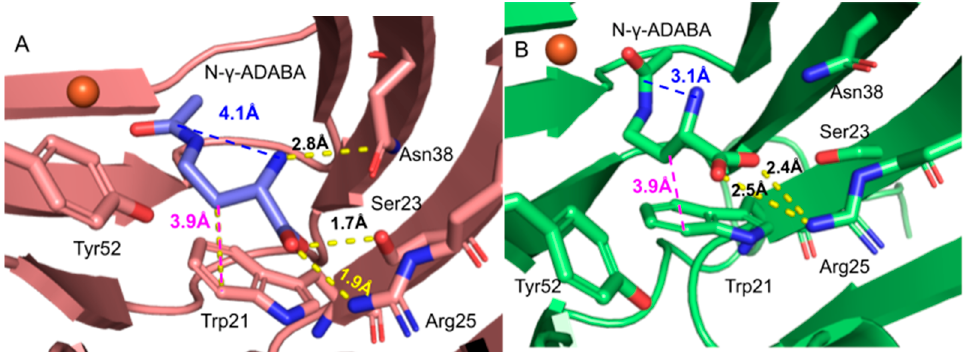
Figure 11. The representative geometries extracted from two MD windows: ( A ) centroid approxi- mating the minimum on the plot, ( B ) centroid approximating a hypothetical NAC. Yellow dashed lines show hydrogen bonds present in given geometry of an active site, blue dotted line indicates the C2-N2 distance in the substrate and magenta dotted line shows the distance between the substrate (C4 carbon atom) and the indole ring of Trp21 (CZ2 carbon atom).